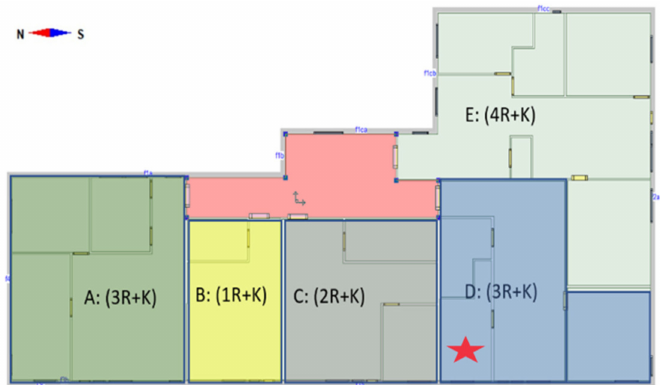
Figure 5. The location of the warmest bedroom in the buildings (red